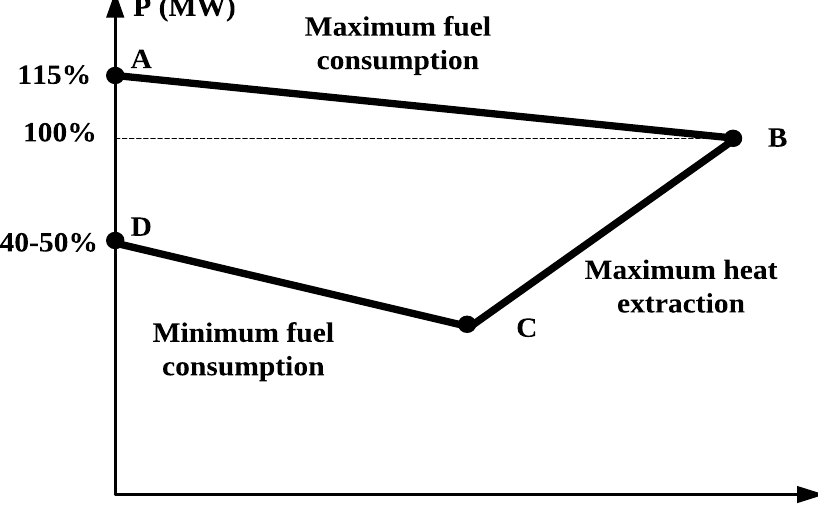
Figure 1. Convex feasible operation region (FOR) of CHP